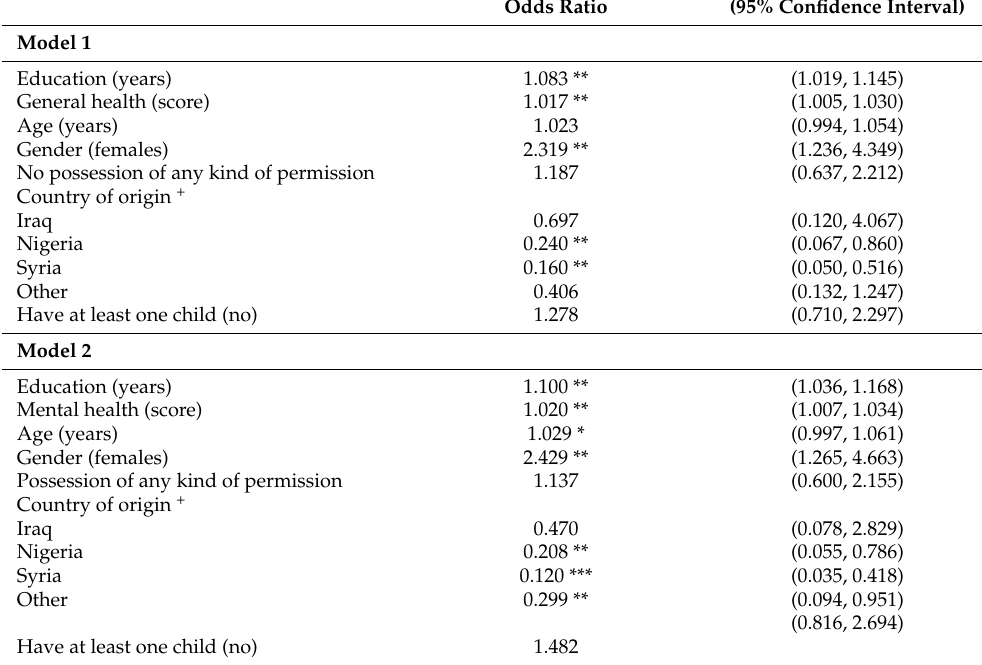
Table 6. Logistic regression models that investigated the impact of quality of life, presence of any kind of permission and demographics on migrants brushing their teeth daily (dependent